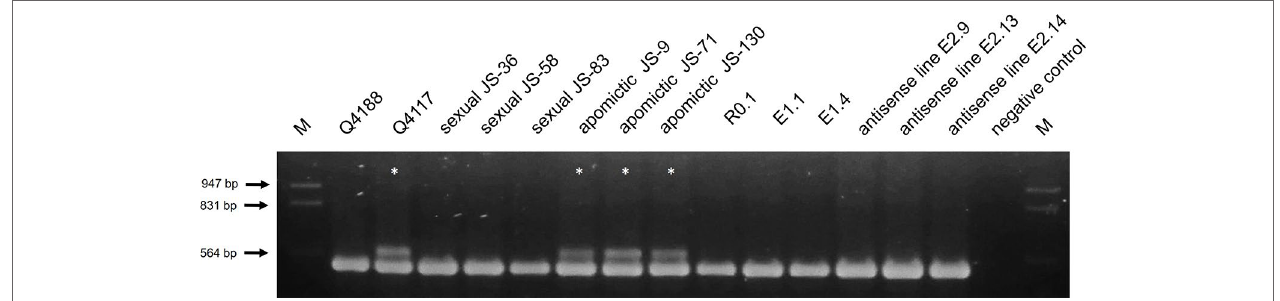
FIGUre 5 | Apospory-controlling region (ACR) amplification in antisense and control lines (sexual and apomictic). Genomic DNA of genotypes Q4188 (sexual), Q4117 (apomictic), three sexual and three apomictic F 1 hybrids originated from a cross Q4188 x Q4117, R0.1 (regeneration control), E1.1 and E1.4 (transformation controls), and E2.9, E2.13, E2.14 (antisense lines) were used as templates to investigate the presence of the ACR with primers that specifically amplify a copy of a PPIASE located within this genomic region (Pupilli et al., 2004; Podio et al., 2012). Only Q4117 and the three apomictic F 1 hybrids amplified the ACR-specific band.